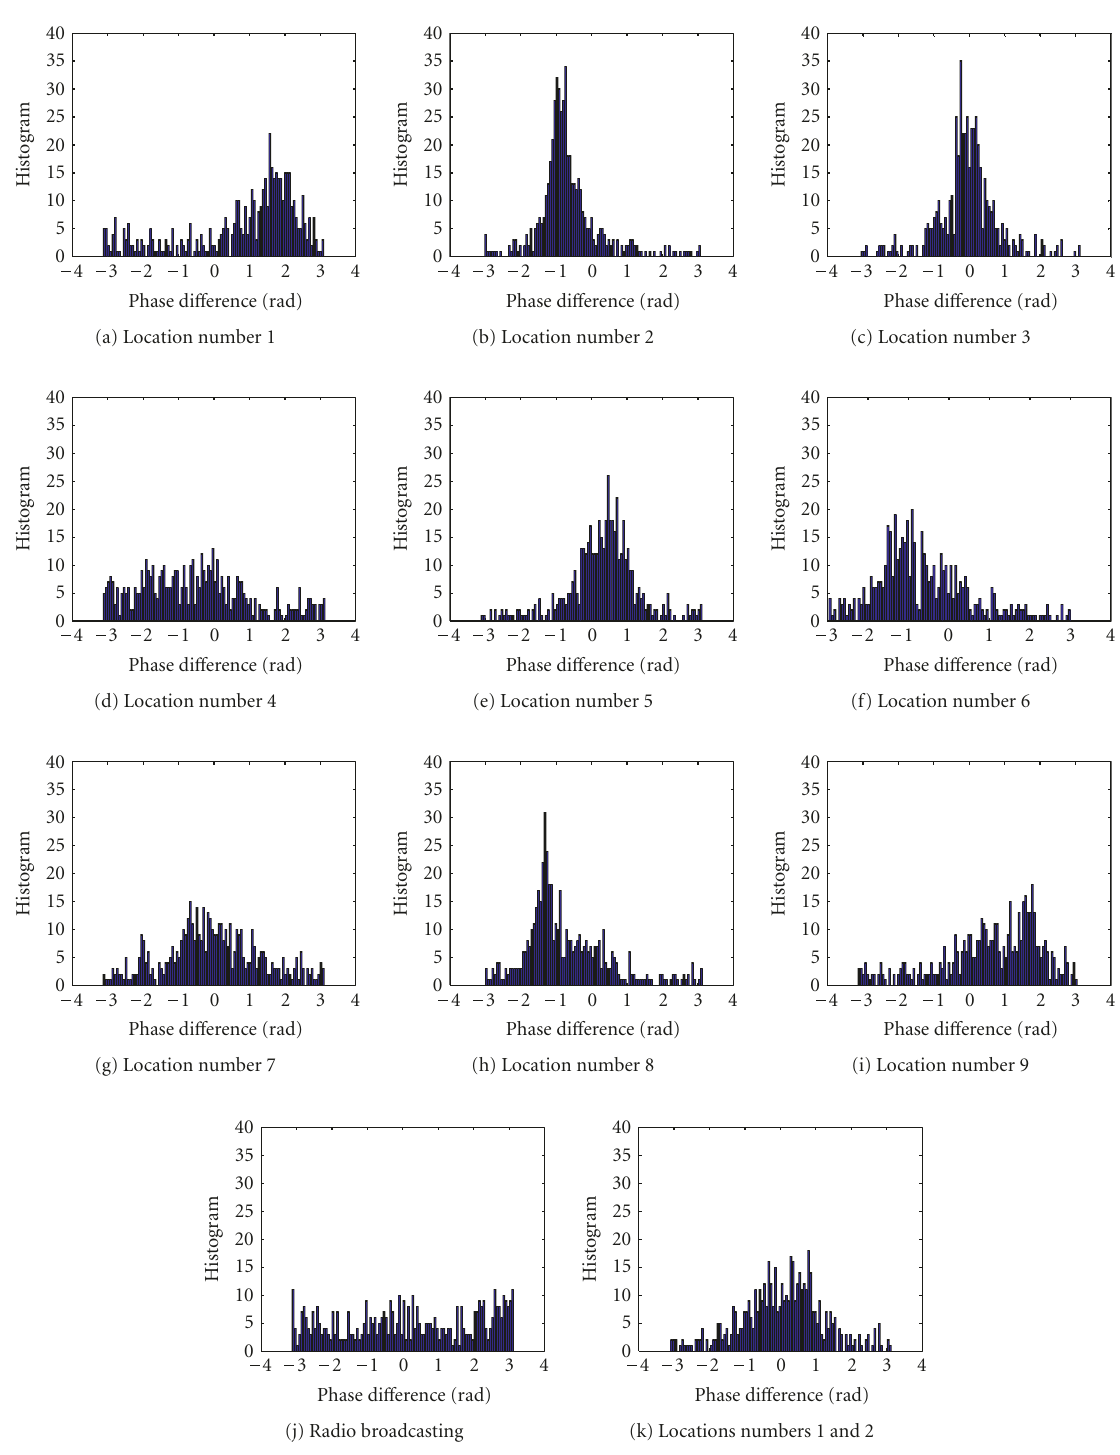
Figure 5: Various histograms of phase di ff